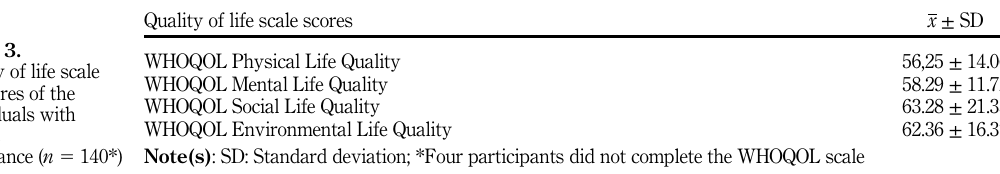
Table 4. Participants ’ VAS scores of discomfort experienced due to common symptoms in lactose intolerance ( n 5